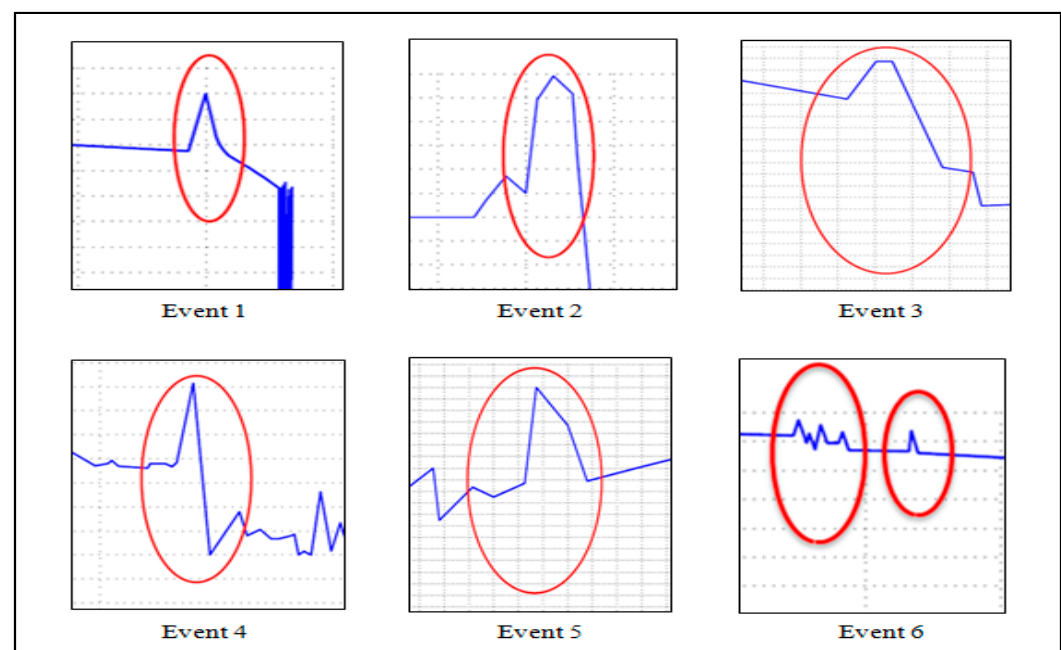
Figure 13. Failure detection pattern shape.